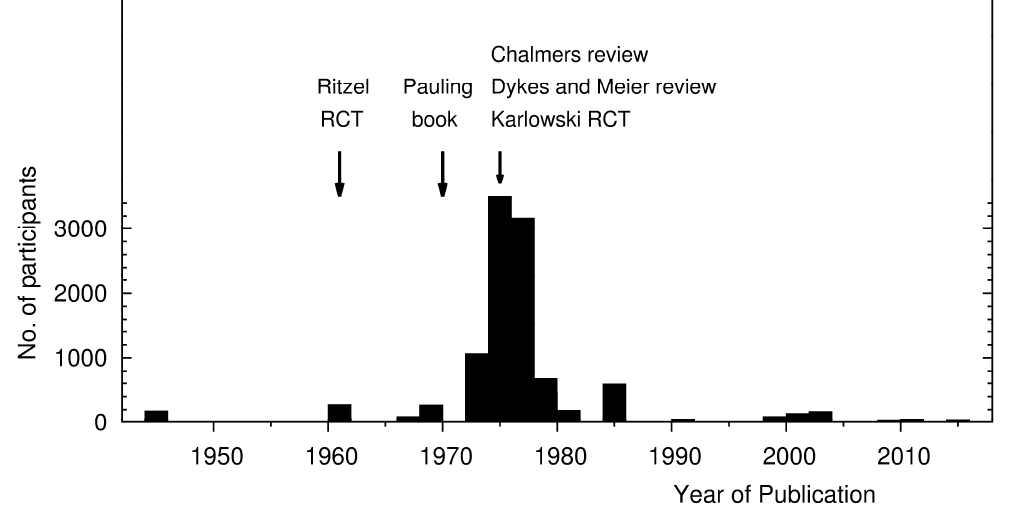
Figure 1. The numbers of participants in the placebo ‐ controlled trials for which ≥ 1 g/day of vitamin C was administered. The numbers of participants in studies published over two consecutive years are combined and plotted for the first of the two years. This figure is based on data collected by Hemilä and Chalker (2013) [68,69]. See Supplementary file 1 of this review for the list of the studies. RCT, randomized controlled